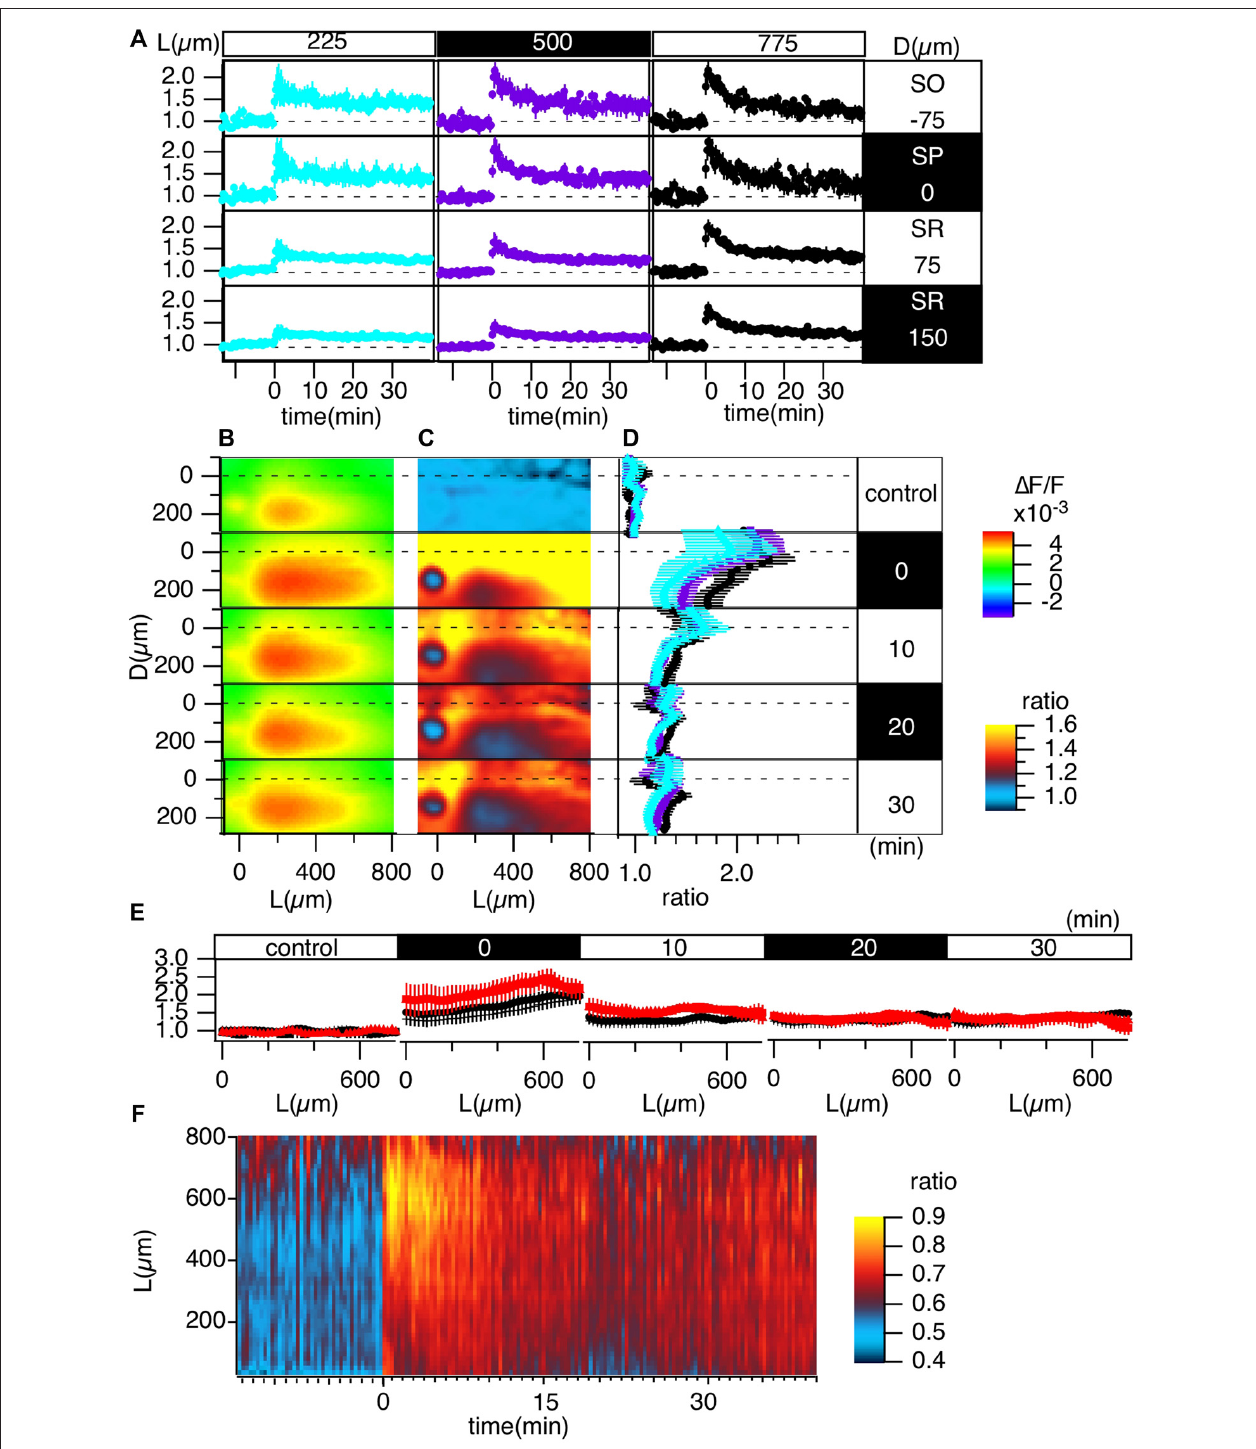
FIGURE 5 | Grouped evaluation of high-frequency stimulation (HFS)-induced LTP. The same analysis of LTP is shown in Figure 3 , but the induction protocol is 100 pulses of 100 Hz (HFS). (A) The time changes in normalized peak amplitude of the optical signals at representative points at three different L positions [ L = 225 (cyan), 500 (purple), 775 (black) µ m] and four different D positions ( D = − 75, 0, 75, 150 µ m). (B) The peak values mapped in the D-L coordinates. (C) The LTP ratio in the D-L coordinates. (D) The line profiles of C at different L positions [225 (cyan), 500 (purple), 775 (black) µ m] at each time point. (E) The line profile along the L axis at different time sections for control recordings and recordings made at 0, 10, 20 and 30 min from TBS. (F) The time change in the ratio of the line profiles at the SO ( D = − 75) vs. the SR ( D = 150), i.e., the PRR along the L axis. N = 2, n = 7, bars in (A,D,E) indicate SEM.